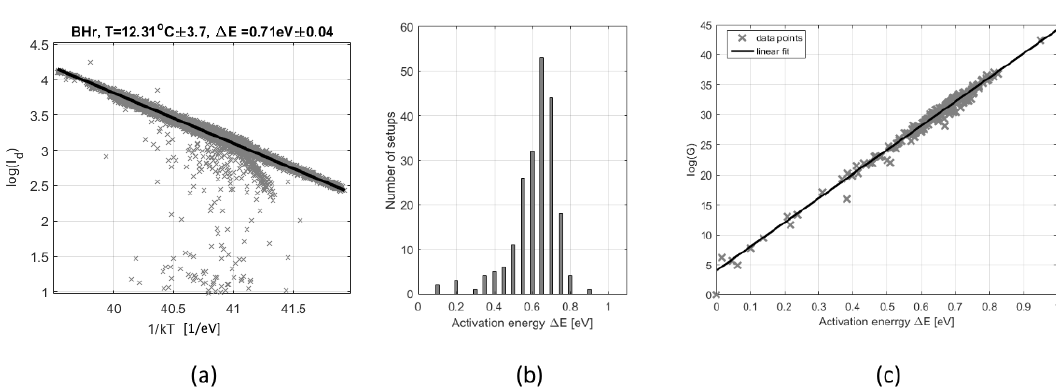
Figure 2. Selected plots from the previous study [14]: ( a ) an exemplary thermal dependency of DC in a random pixel, ( b ) the histogram of estimated activation energies of mean DC in CCDs, ( c ) the confirmation of NMR rule in BRITE